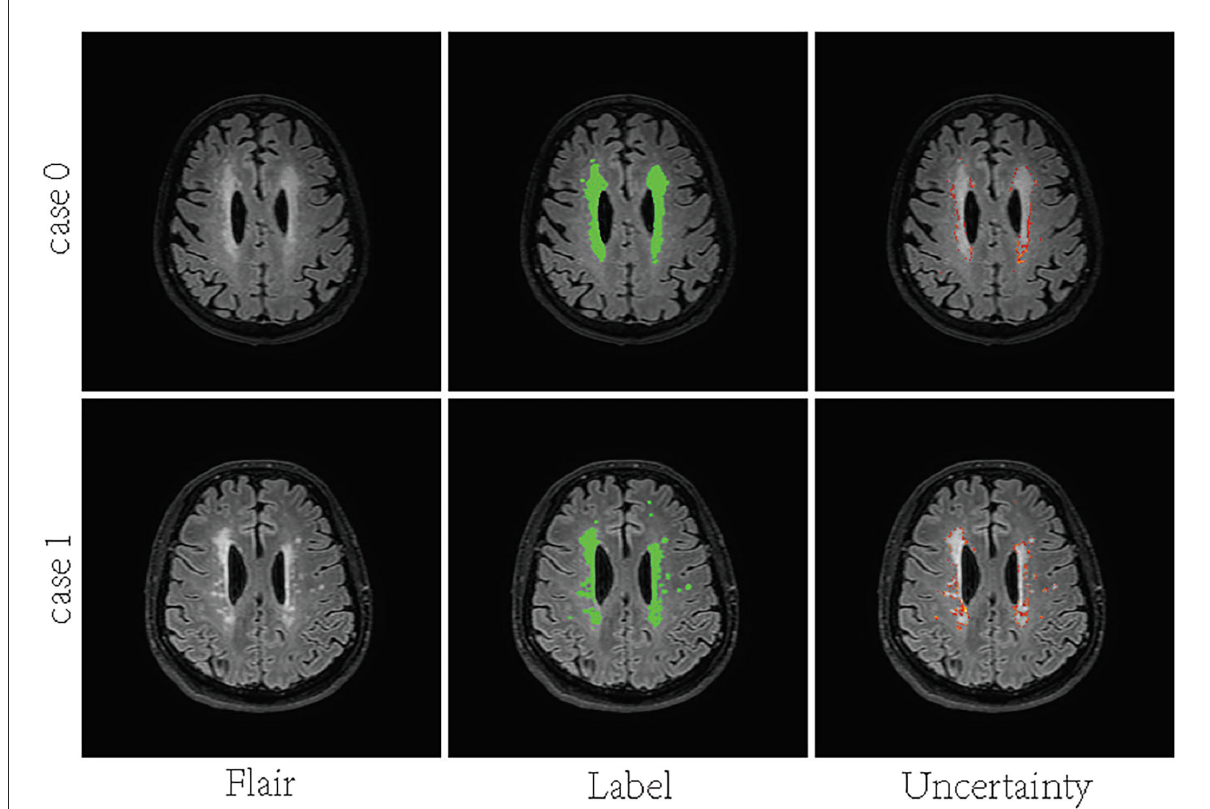
FIGURE1 Visualization of uncertainty maps on two training slices computed by Bayesian U-Net. From left to right: Flair MR images, the associated ground truth, and the associated uncertainty